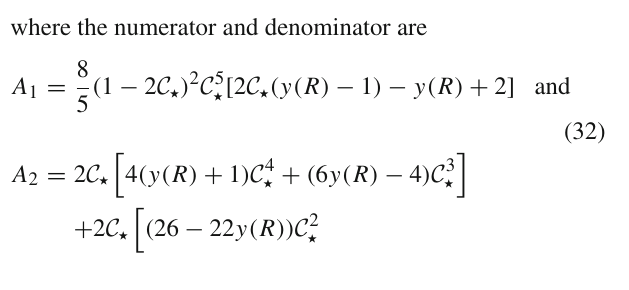
Fig. 11 Parametric space for the Lane–Emden equation (α = β = 0 ) with mass density (top plates) and energy density (bottom plates), for models with polytropic index from n = 0 . 5 to n = 4 . 0, and parameters